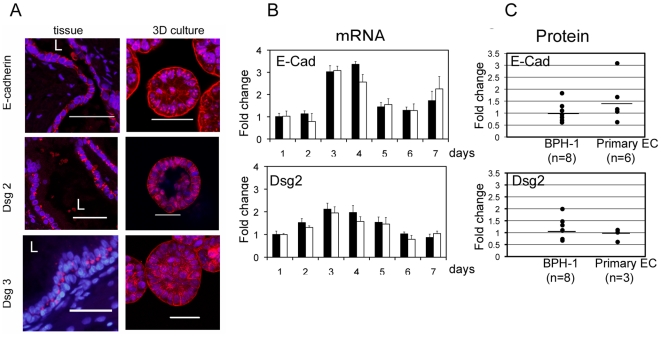
Stroma does not effect E-cadherin or Dsg2 mRNA or protein expression levels.(A). The localisation of E-cadherin and Desmogleins in human tissue and BPH-1 acini sections by immunostaining for E-cadherin, Dsg2 or Dsg3 (red) (A). Nuclei were counterstained with DAPI (blue), bars  = 50 µm, L  =  lumen. (B). TaqMan assay was performed on mRNA isolated from 3D BPH-1 acini cultured with (white bars) or without stroma (black bars), over 7 days culture shows that stroma does not increase E-Cadherin or Dsg2 mRNA expression at any time-point. The average fold difference in gene expression was expressed relative to GAPDH. Error bars represent standard deviation of three replicates and the experiment was reproduced twice. (C). Quantitative western blotting was performed on BPH-1 cells or primary epithelial cultures (primary-EC) grown in Matrigel with or without stroma. The levels of E-cadherin or Dsg2 protein expression did not significantly increase in either BPH-1 acini or primary acini cultured in the presence of stroma. Protein levels were measured by densitometric analysis and normalised to β-actin. A mean fold change in protein expression was calculated for cells grown with stroma in comparison to those without stroma. Individual experiments are represented as dots and the mean value is shown by the bar.